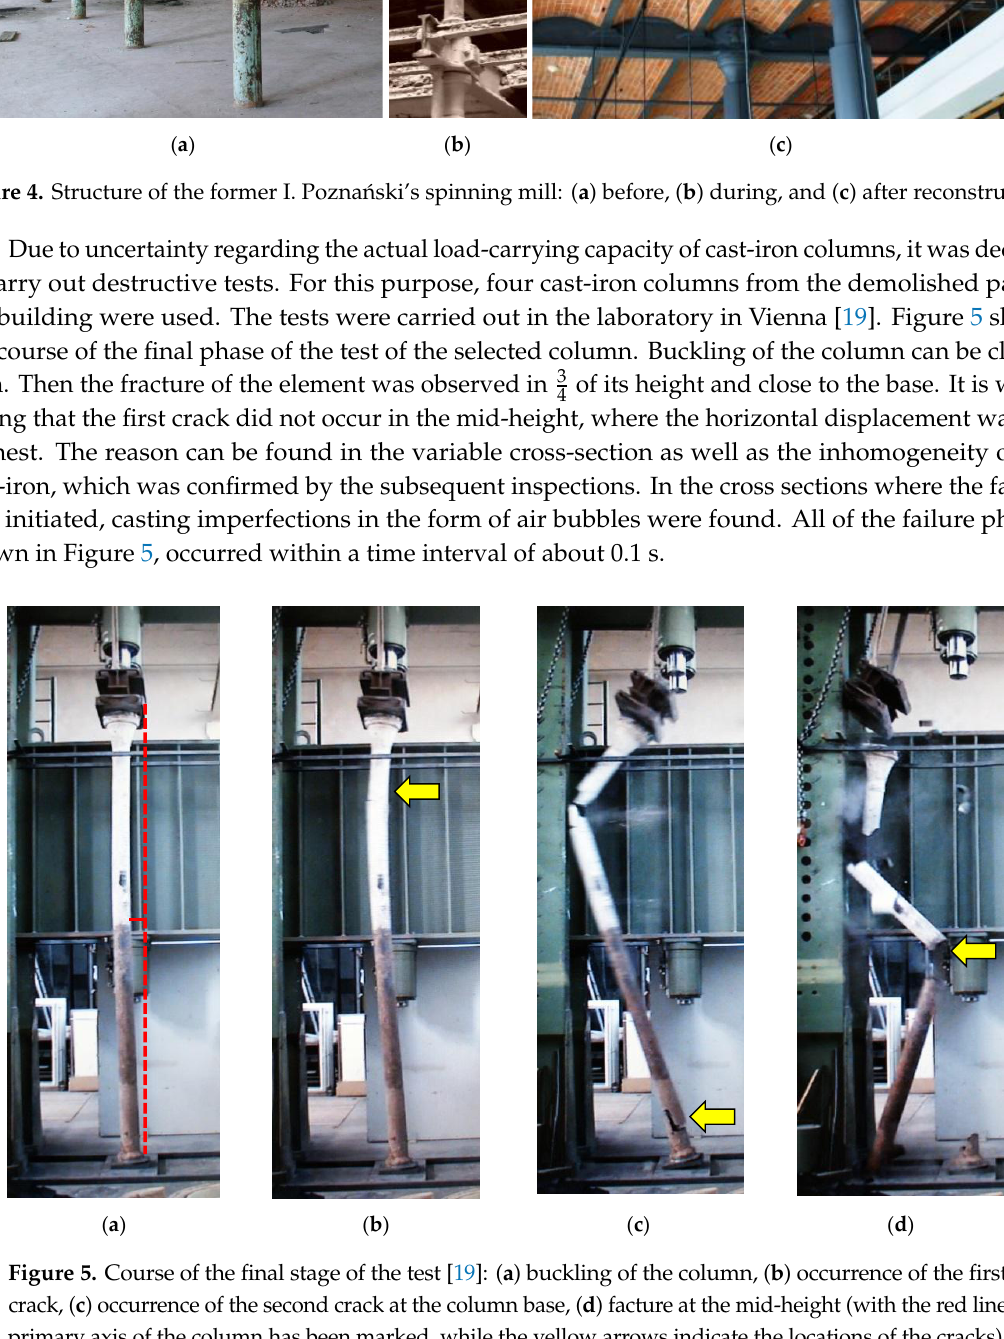
Figure 4. Structure of the former I. Poznański’s spinning mill: ( a ) before, ( b ) during, and ( c ) after reconstruction.